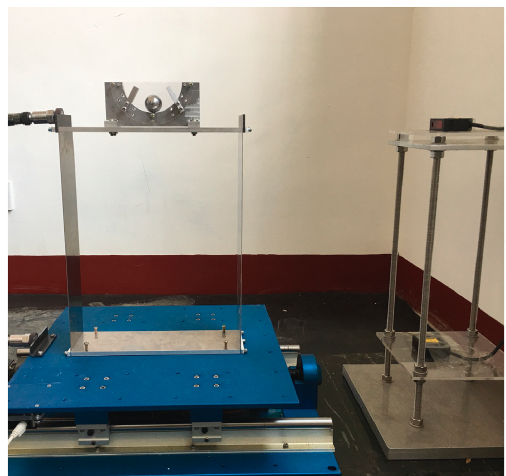
Figure 23: Photograph of the test structure.